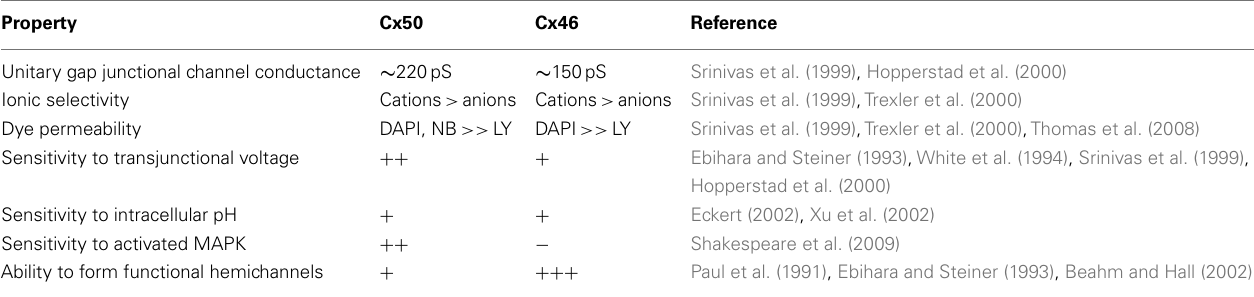
Table 4 | Physiological properties of wild type Cx50 and Cx46.